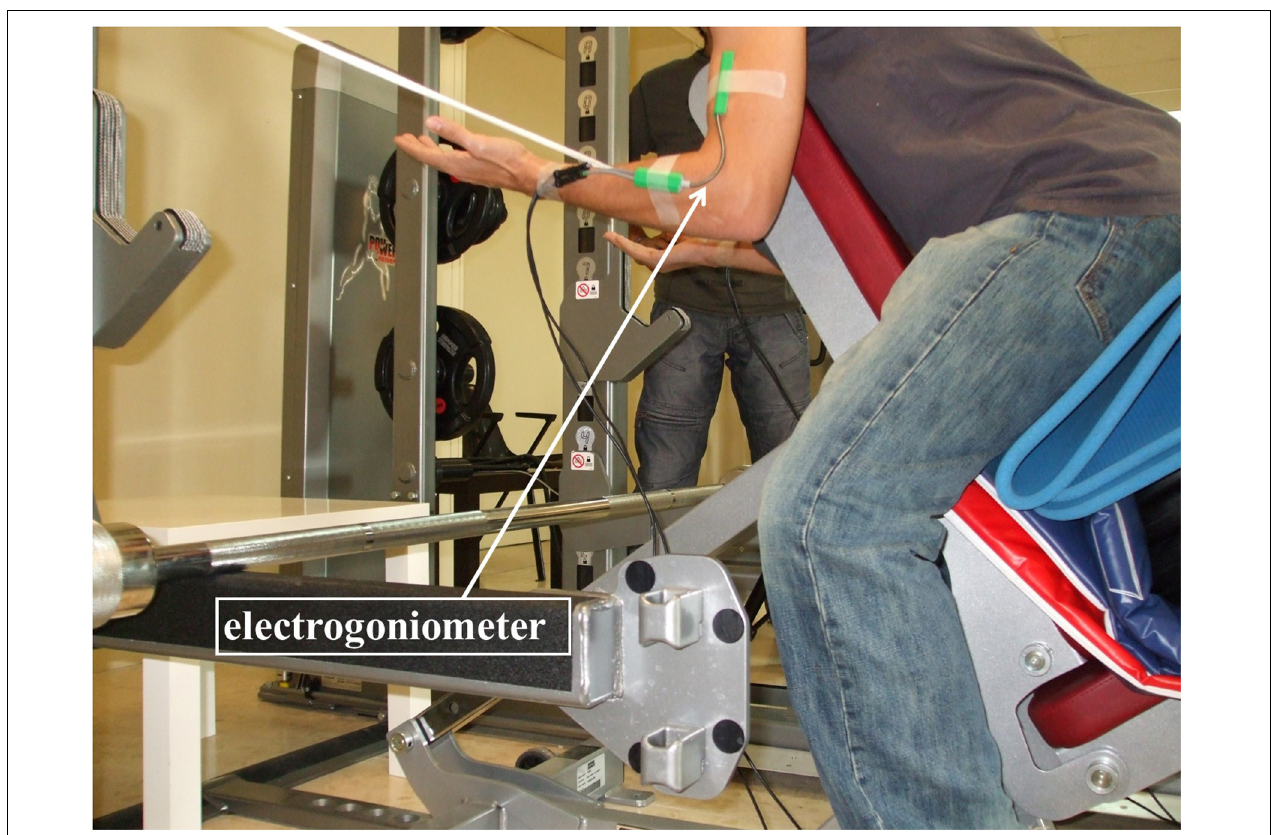
FIGURE 1 | Participant in preparation for the task. The sensors of the electrogoniometer were placed on the upper arm and forearm of both